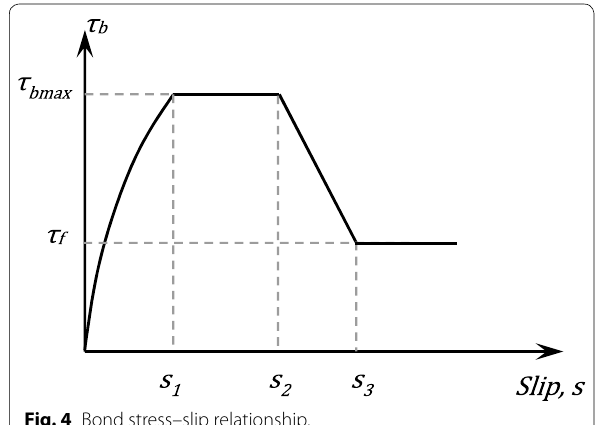
Fig. 4 Bond stress–slip